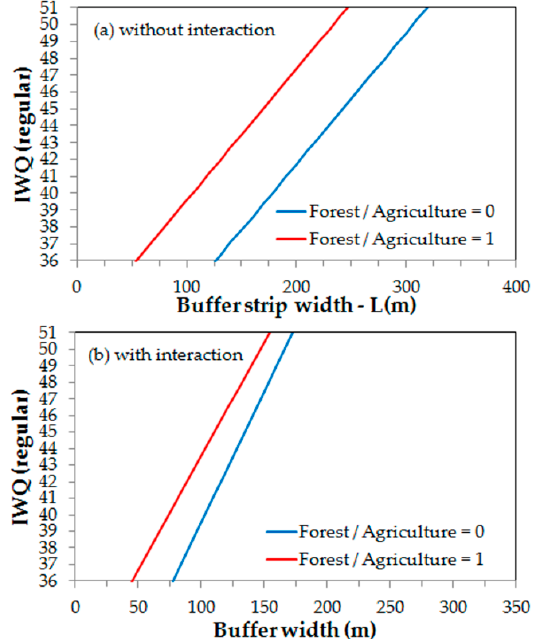
Figure 7. Interaction multiple regression plots: ( a ) No interaction model; ( b ) interaction model.